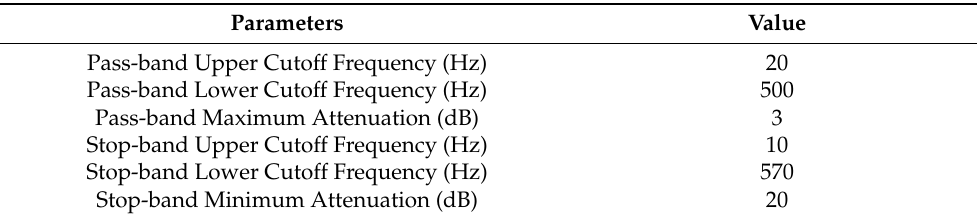
Table 1. Main parameters of band-pass filter.